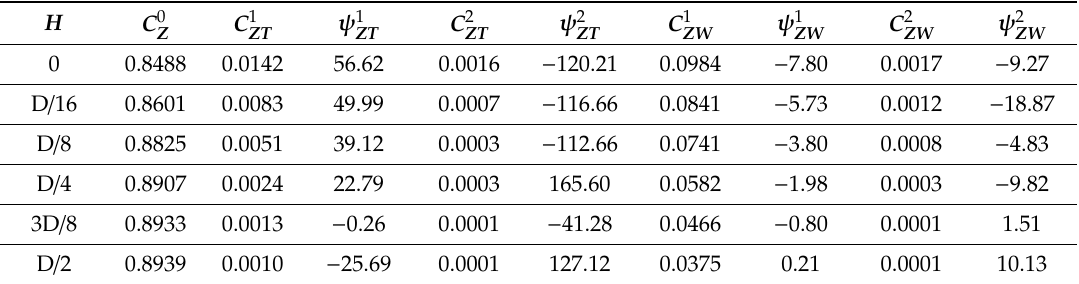
Expansion coe ffi cient table of axial load coe ffi cient under the di ff erent blade tip immersion depths.